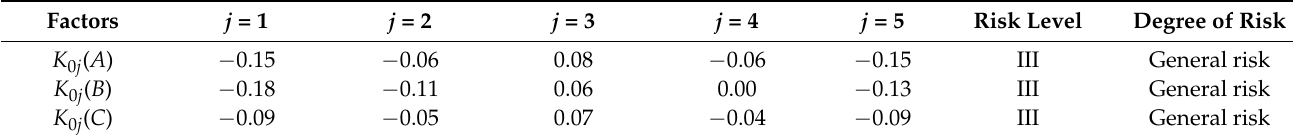
Table 5. Risk Level of Shanghai ICCL Safety Supervision factors.